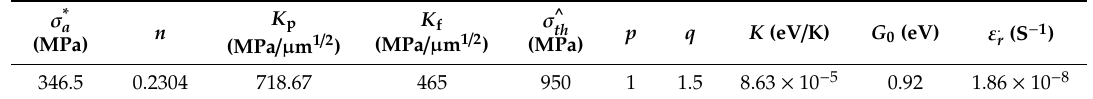
Table 4. Optimized values of the model parameters